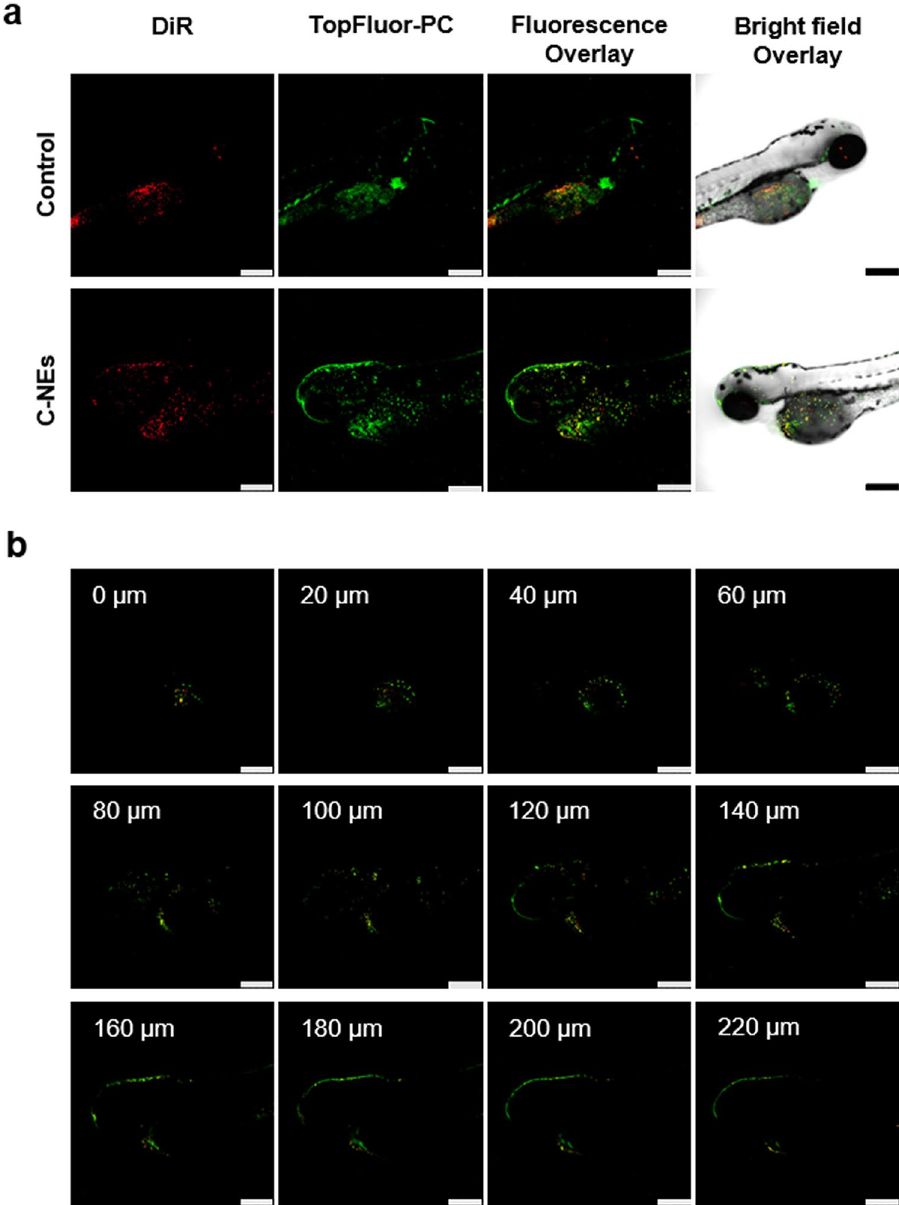
Figure 5. Confocal microscopy images of 72 hpf zebrafish embryos ( a ) incubated with 500 µg/mL of C-NEs labeled with DiR and TopFluor-PC, for 4 h at 34 °C. Control refers to non-treated zebrafish, which present auto-fluorescence. Scale bars correspond to 250 µm. ( b ) Z-stack images. Red channel: DiR. Green channel: